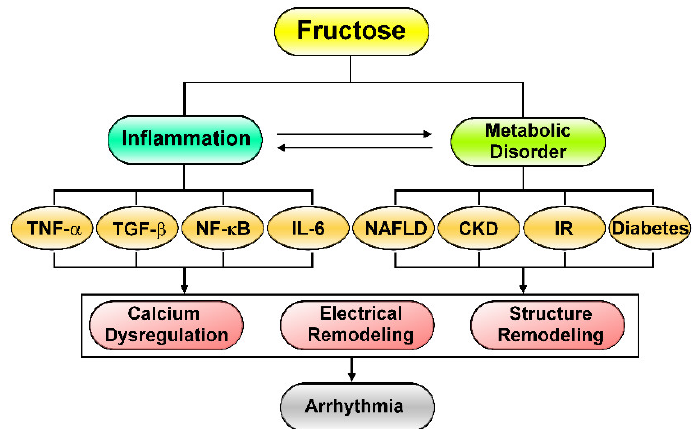
Figure 1. Effects of excessive fructose intake on cardiac remodeling and arrhythmia. Excessive fructose intake promotes inflammation and stimulates metabolic disorders, leading to cardiac ar- rhythmogenesis and aggravating its negative effects on cardiac remodeling and arrhythmia. (Left) Fructose that potentiates inflammatory signaling (TNF- α , TGF- β , NF- κ B, and IL-6). (Right) Fructose that activates metabolic disease (NAFLD, CKD, IR, and diabetes). TNF- α : tumor necrosis factor alpha, TGF- β : transforming growth factor beta, NF- κ B: nuclear factor kappa B, IL-6: interleukin 6,